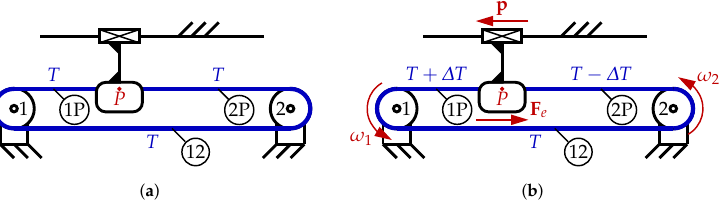
Figure 7. (a) : schematic of a simple, 1-DoF, overactuated belt routing, under static conditions. (b) : same, under dynamic conditions. Belt tensions are also shown for both conditions.